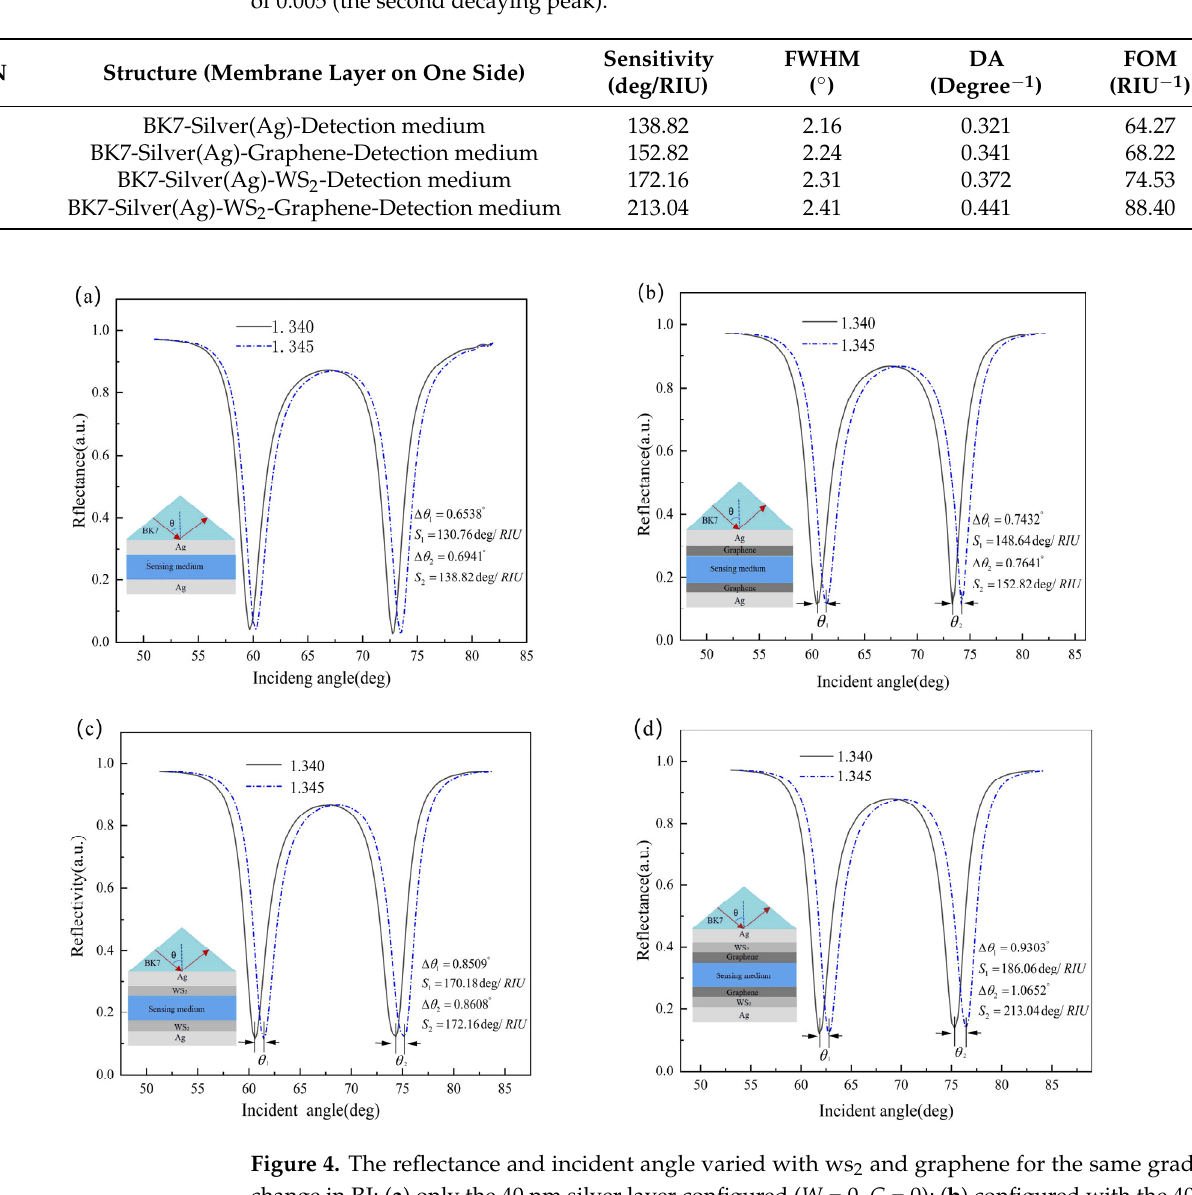
Table 3. The performance of the above four structures at a medium refractive index change gradient of 0.005 (the second decaying peak).